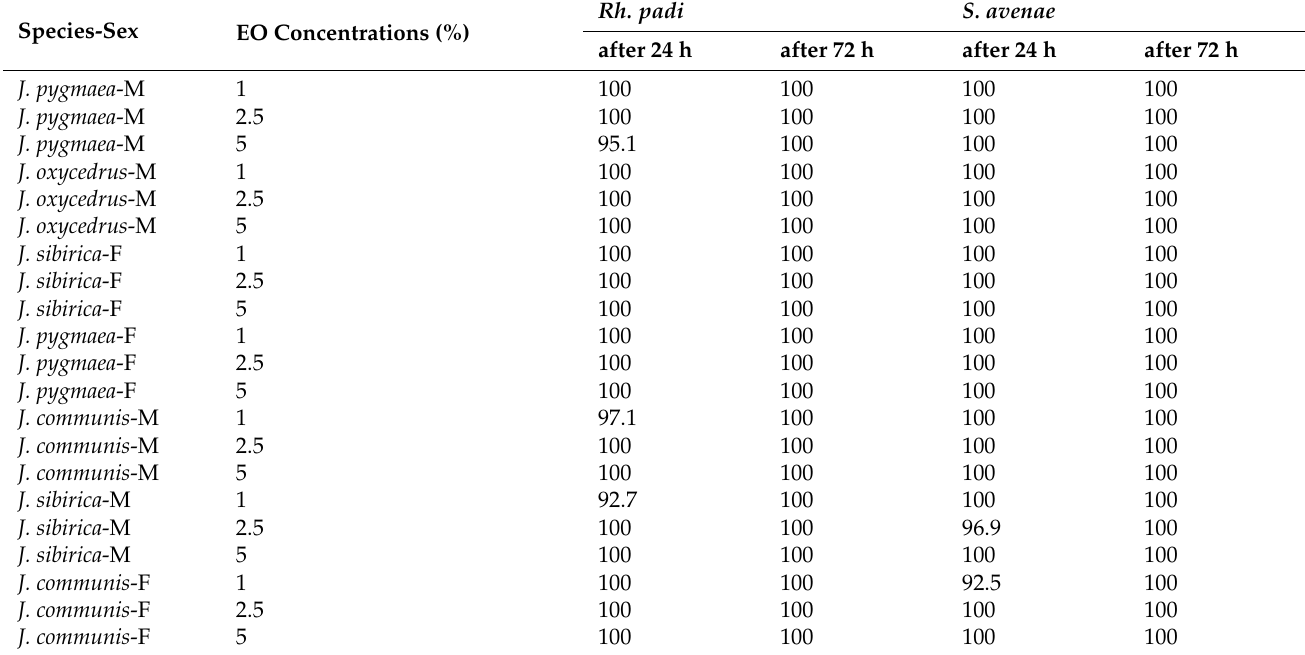
Table 7. The insecticidal effect of semi-commercial extraction EOs of J. pygmaea (M, F), J. oxycedrus (M, F), J. sibirica (M, F) and J. communis (M, F) on two aphids ( Rhopalosiphum padi, Sitobion avenae ).